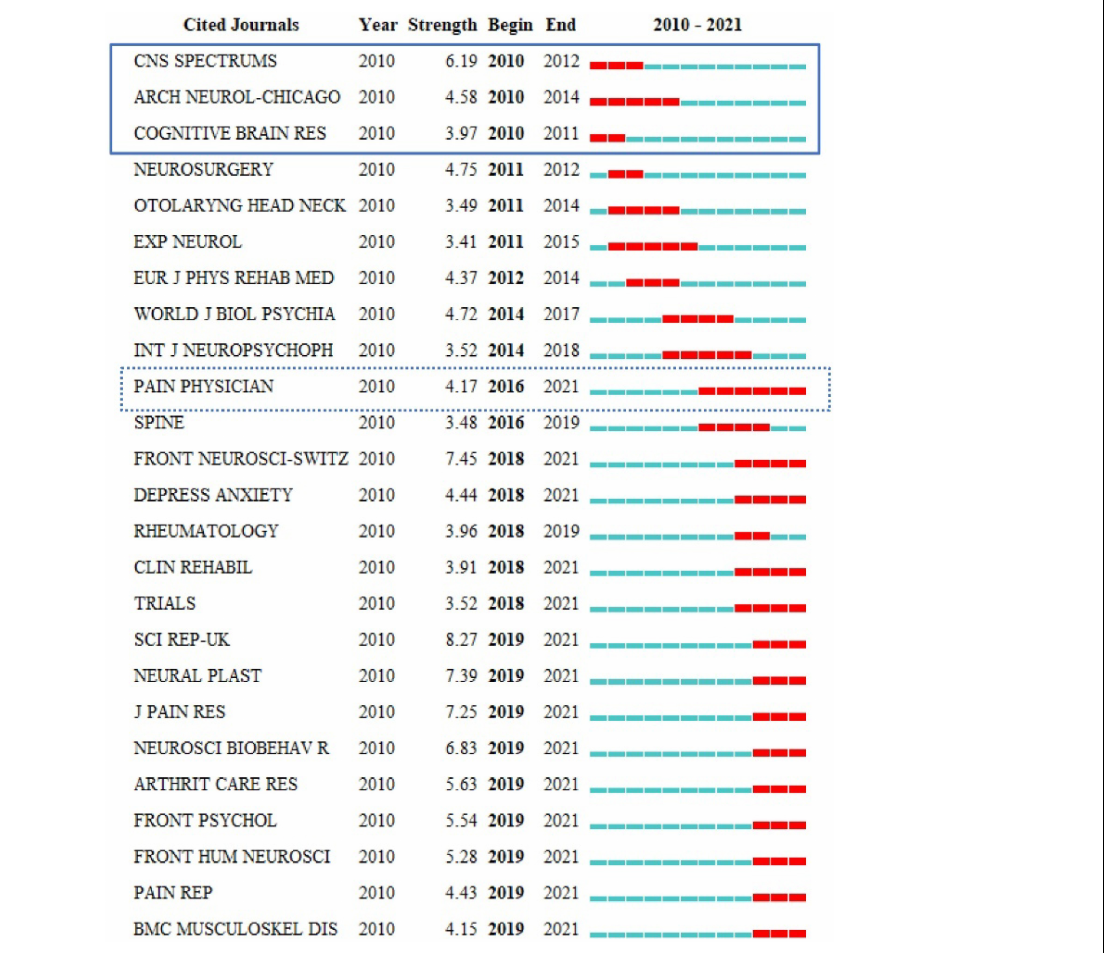
FIGURE 3 | Top 25 cited journals with the strongest citation